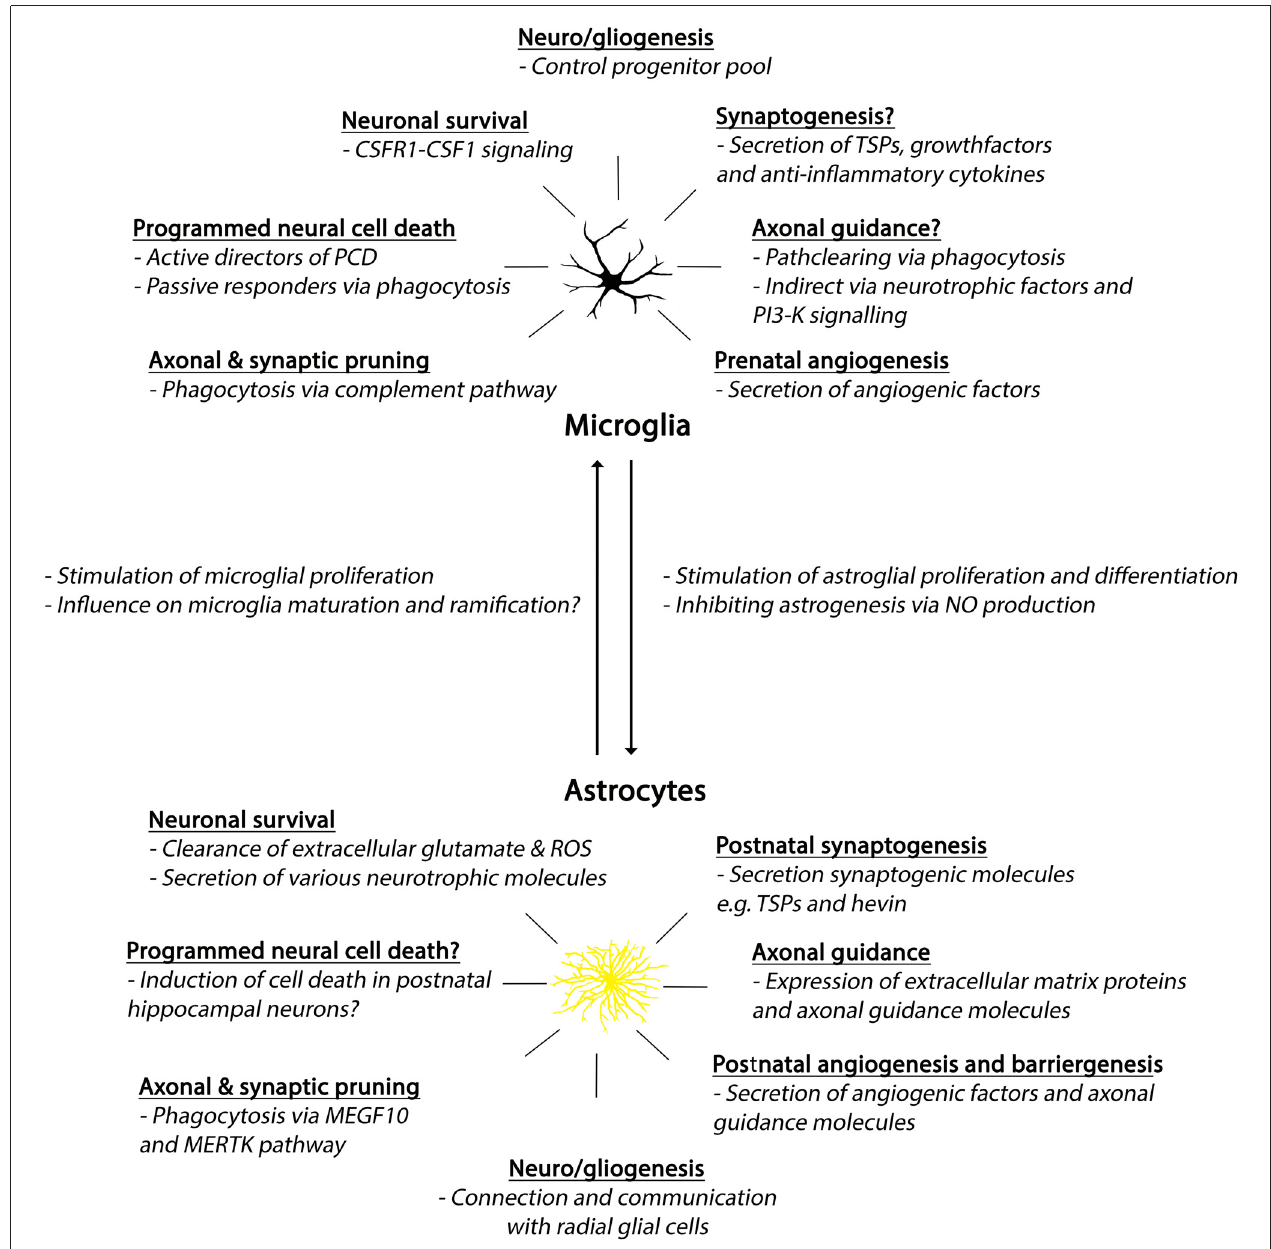
FIGURE 3 | Summary of developmental roles of microglia and astrocytes. Abbreviations: CSFR1, colony-stimulating factor 1 receptor; CSF1, colony-stimulating factor 1; PCD, programmed cell death; TSPs, thrombospondins; PI3-K, phosphoinositide-3 kinase; ROS, reactive oxygen species; MEGF10, Multiple EGF-like-domains 10; MERTK, MER Tyrosine